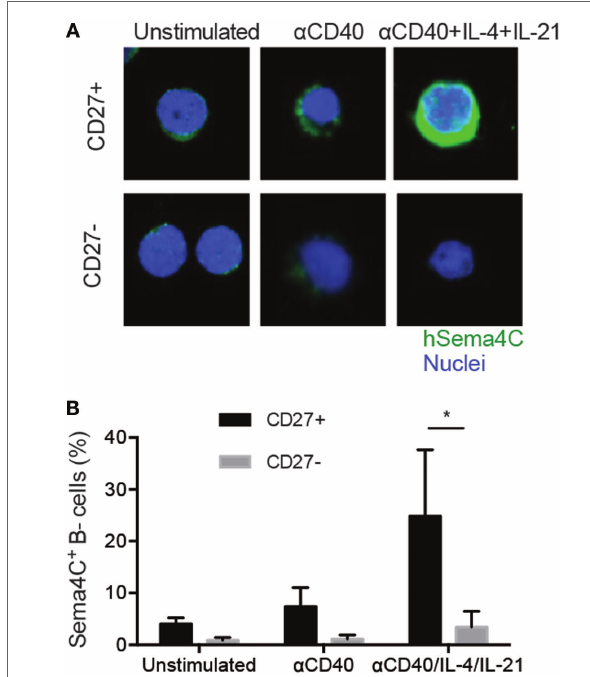
FigUre 7 | sema4c is preferentially induced on memory B-cells . Isolated human tonsillar B-cells were purified into CD27 + and CD27 − populations by magnetic bead separation. (a) Representative immunofluorescence staining image showing Sema4C protein level in CD27 + (upper panel) or CD27 − (lower panel) B-cells stimulated with CD40L ± IL-4 and IL-21 for 5 days. Green: Sema4C, blue: nucleus. (B) . Histogram summarizing the percentage of Sema4C expressing B-cells among total cells stimulated under indicated conditions. Cells were counted by microscopy by two independent evaluators and means compared. Inter-rater reliability showed a variance of < 10%. * p < 0.05, n = 8 experiments.